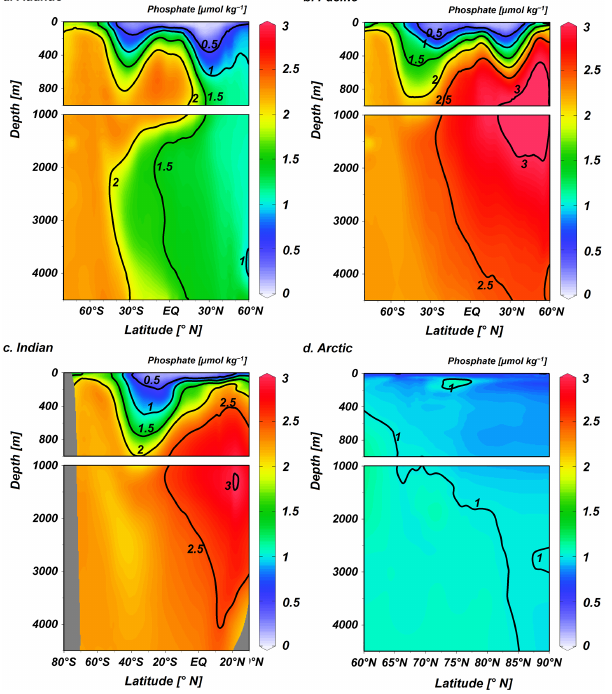
Figure 4. Zonal mean gridded phosphate (in µmolkg − 1 ) in the (a) Atlantic, (b) Pacific, (c) Indian, and (d) the Arctic oceans plotted against latitude and depth.